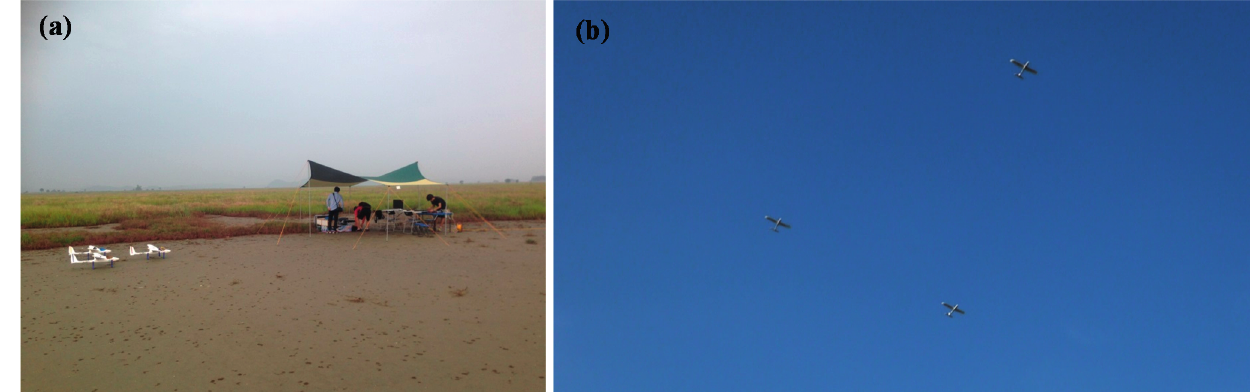
Figure 19. ( a ) Flight test setup; ( b ) Multiple UAVs in close triangular